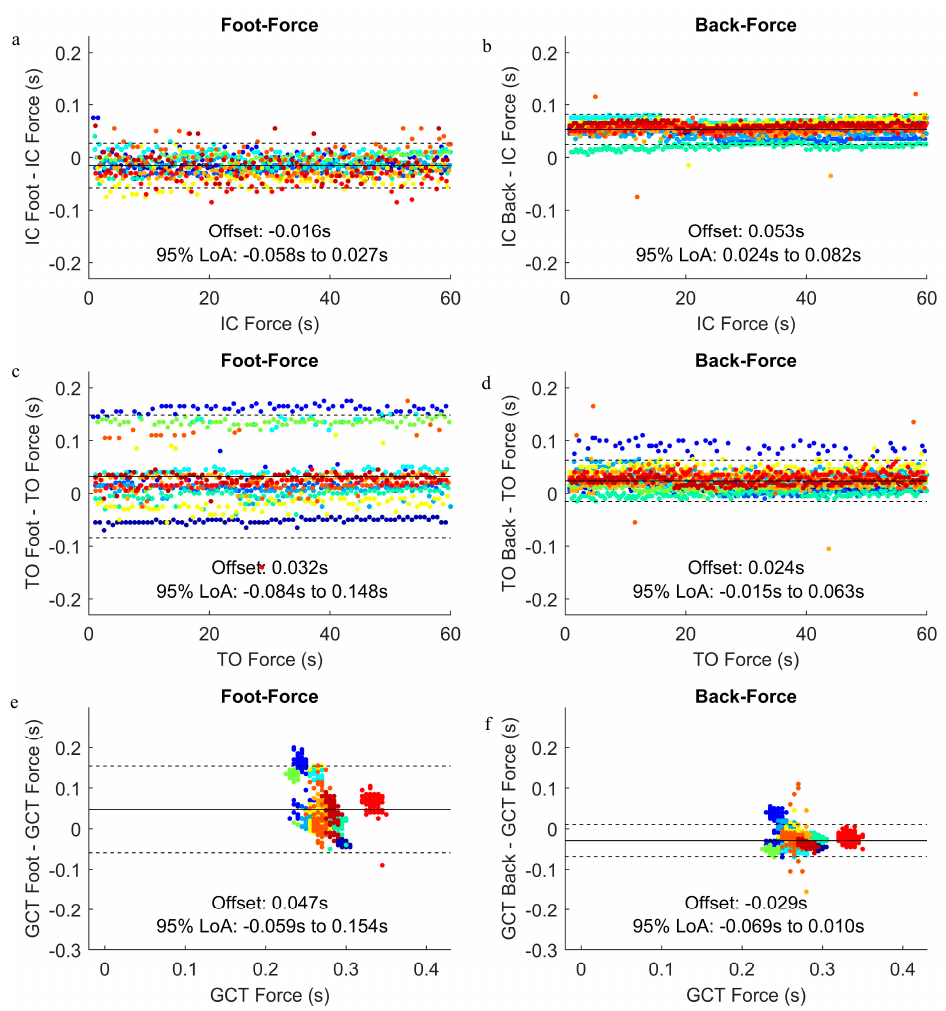
Figure 7. Bland-Altman plots and 95% limits of agreement between the accelerometer-based and force plate-based identification of IC, TO, and GCT over the course of a 60 s running trial. Each dot represents one gait event (IC of TO) or step (GCT), and each participant is plotted with a unique color. The data were processed using a sampling rate of 200 Hz, window size of 2 s, and change in window start time of 0.02 s. The plots are provided for ( a ) IC, foot-force comparison; ( b ) IC, back-force comparison; ( c ) TO, foot-force comparison; ( d ) TO, back-force comparison; ( e ) GCT, foot-force comparison; ( f ) GCT, back-force comparison.